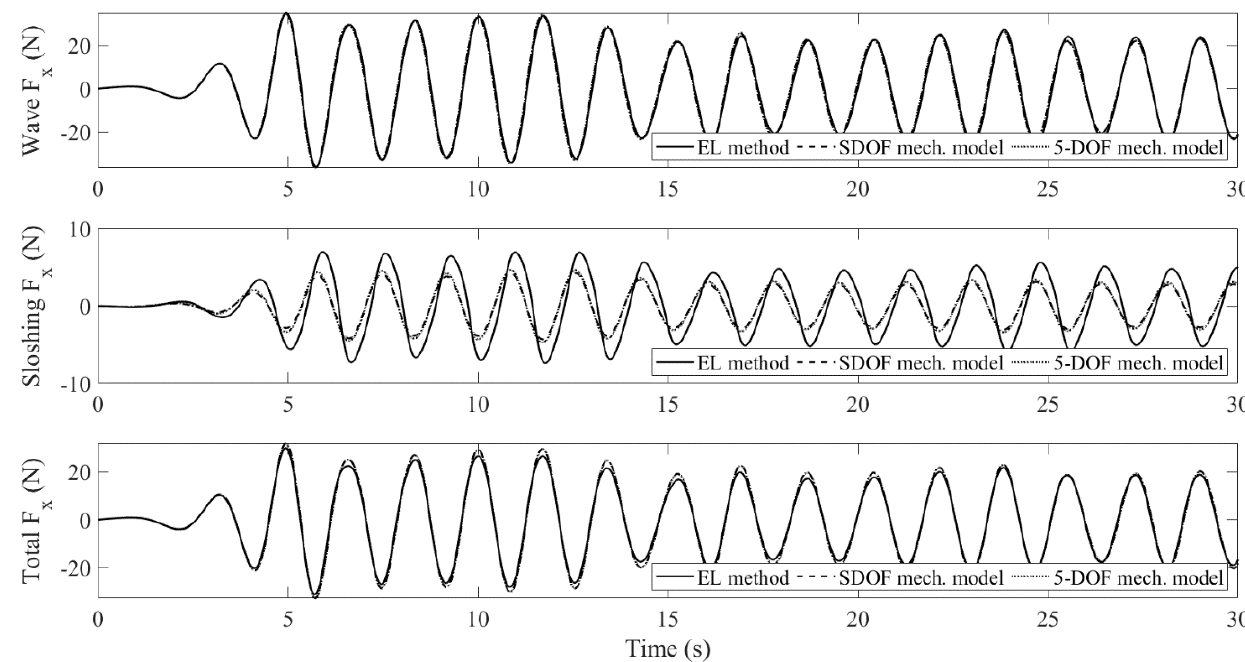
Figure 14. The surge motion responses of the floating body, configured with a water tank installed with porous media, undergoing small wave excitation.